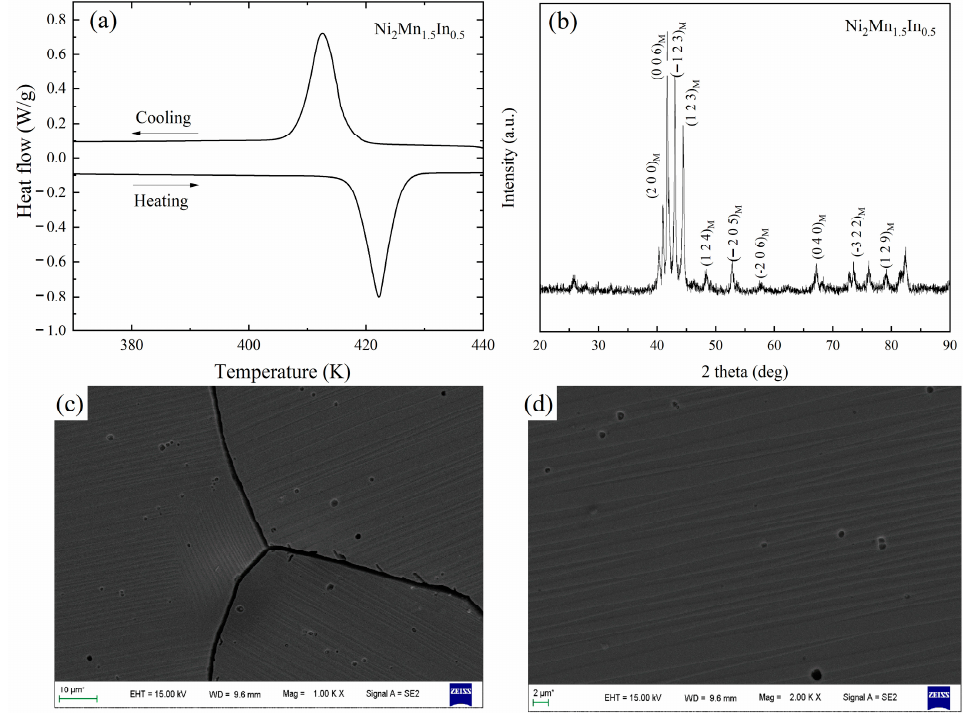
Figure 3. ( a ) DSC curve [30], ( b ) XRD pattern at room temperature [30], ( c , d ) microstructures of Ni 2 Mn 1.5 In 0.5 alloy. Ni 2 Mn 1.5 In 0.5